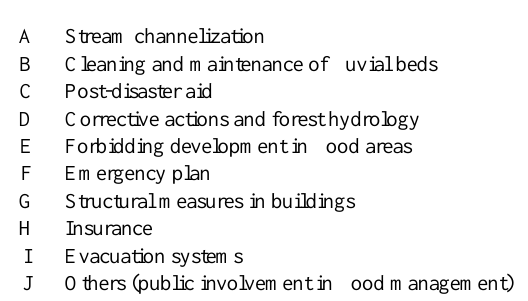
Table 3. Management options cited by mayors and local managers (respect to Fig.